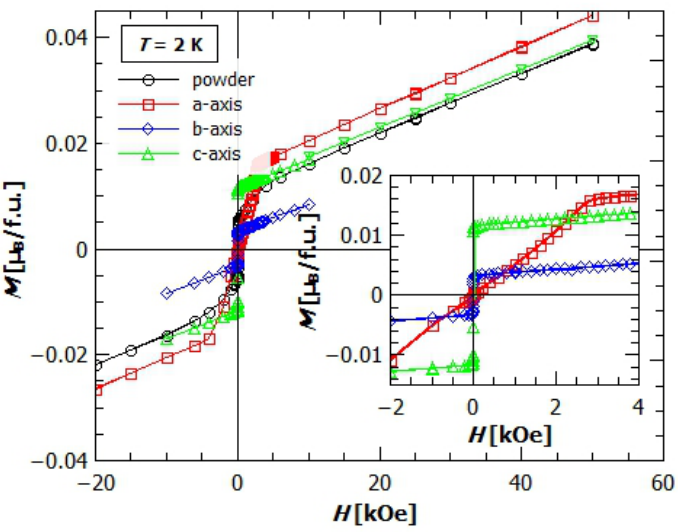
Figure 6. Field dependence of magnetization of the powder and single crystal samples of GuaCuF. Black dots represent powder data, red rectangles the magnetization of single crystal in the direc- tion of the applied field, parallel to a -axis, blue diamonds parallel to b -axis, and green triangles parallel to c -axis.